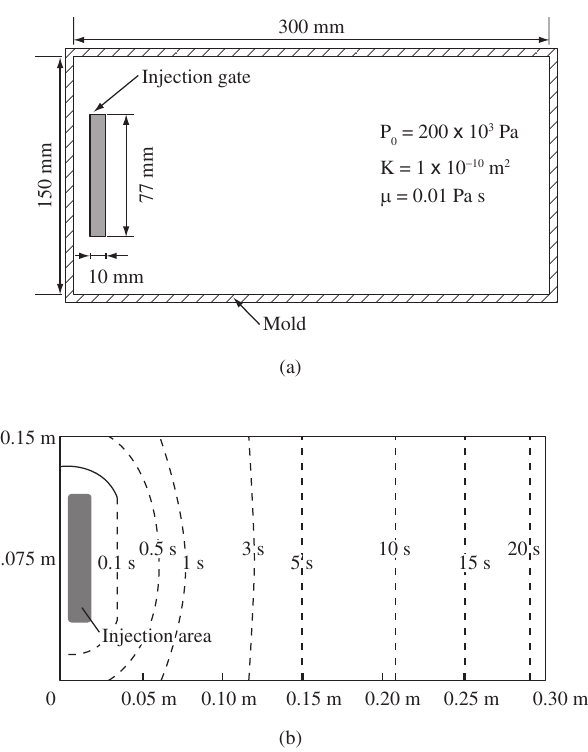
Figure 8. 3D representation of the rectangular mold showing resin flow within the preform 10 a) and a transversal slice presenting the multilayer structure under analysis